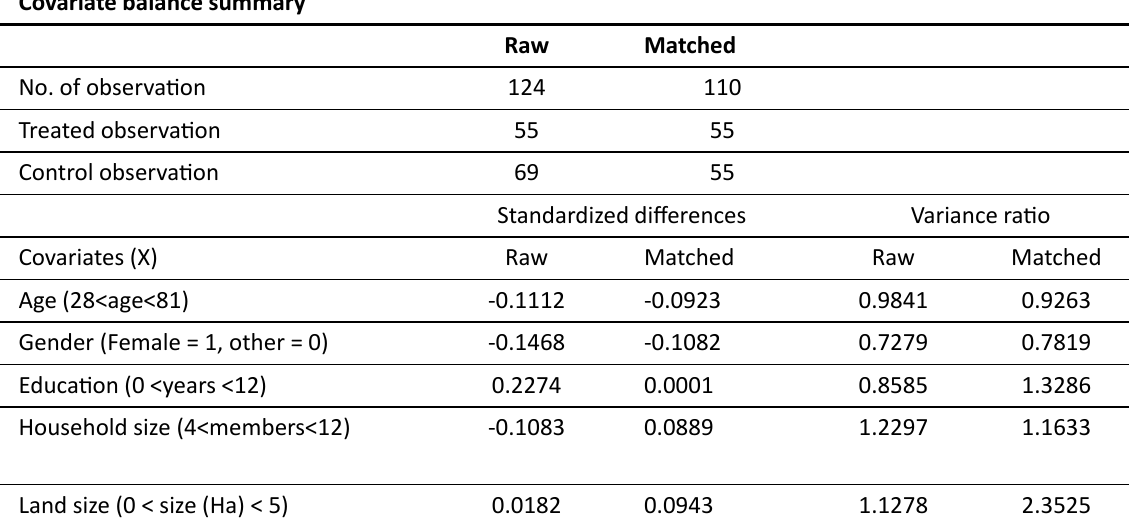
Table 7: Balancing Tests For Propensity Score